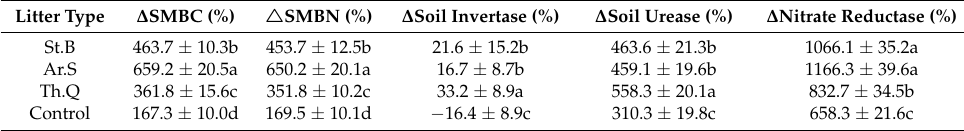
Table 2. The indicators of soil microbial biomass and enzyme activities during litter decomposition.